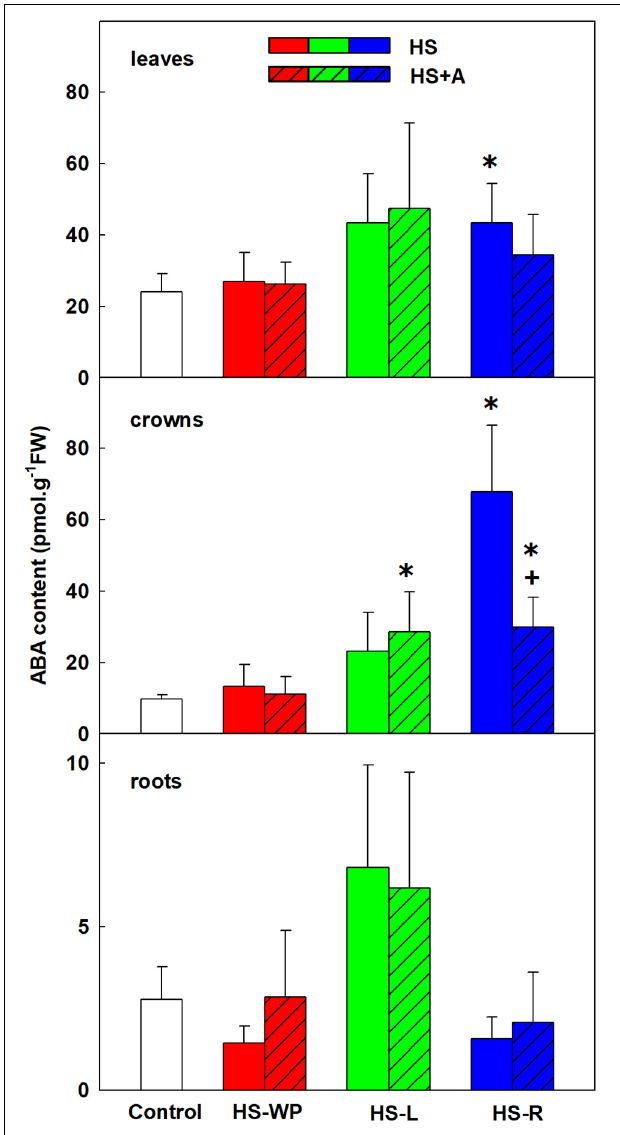
FIGURE 2 | The content of abscisic acid (ABA) in leaves, crowns, and roots of rice seedlings exposed to heat stress directly (HS) or after acclimation (HS + A). Heat stress was applied to whole plants (HS-WP), to leaves (HS-L), or to roots (HS-R). Data are means ± SD. One-way ANOVA with Tukey’s post hoc test ( p < 0.05, n = 6) was used to compare controls to the HS treatments. Significant differences compared to control plants are indicated by asterisks ( ∗ ) while crosses (+) indicate significant differences between HS and HS + A